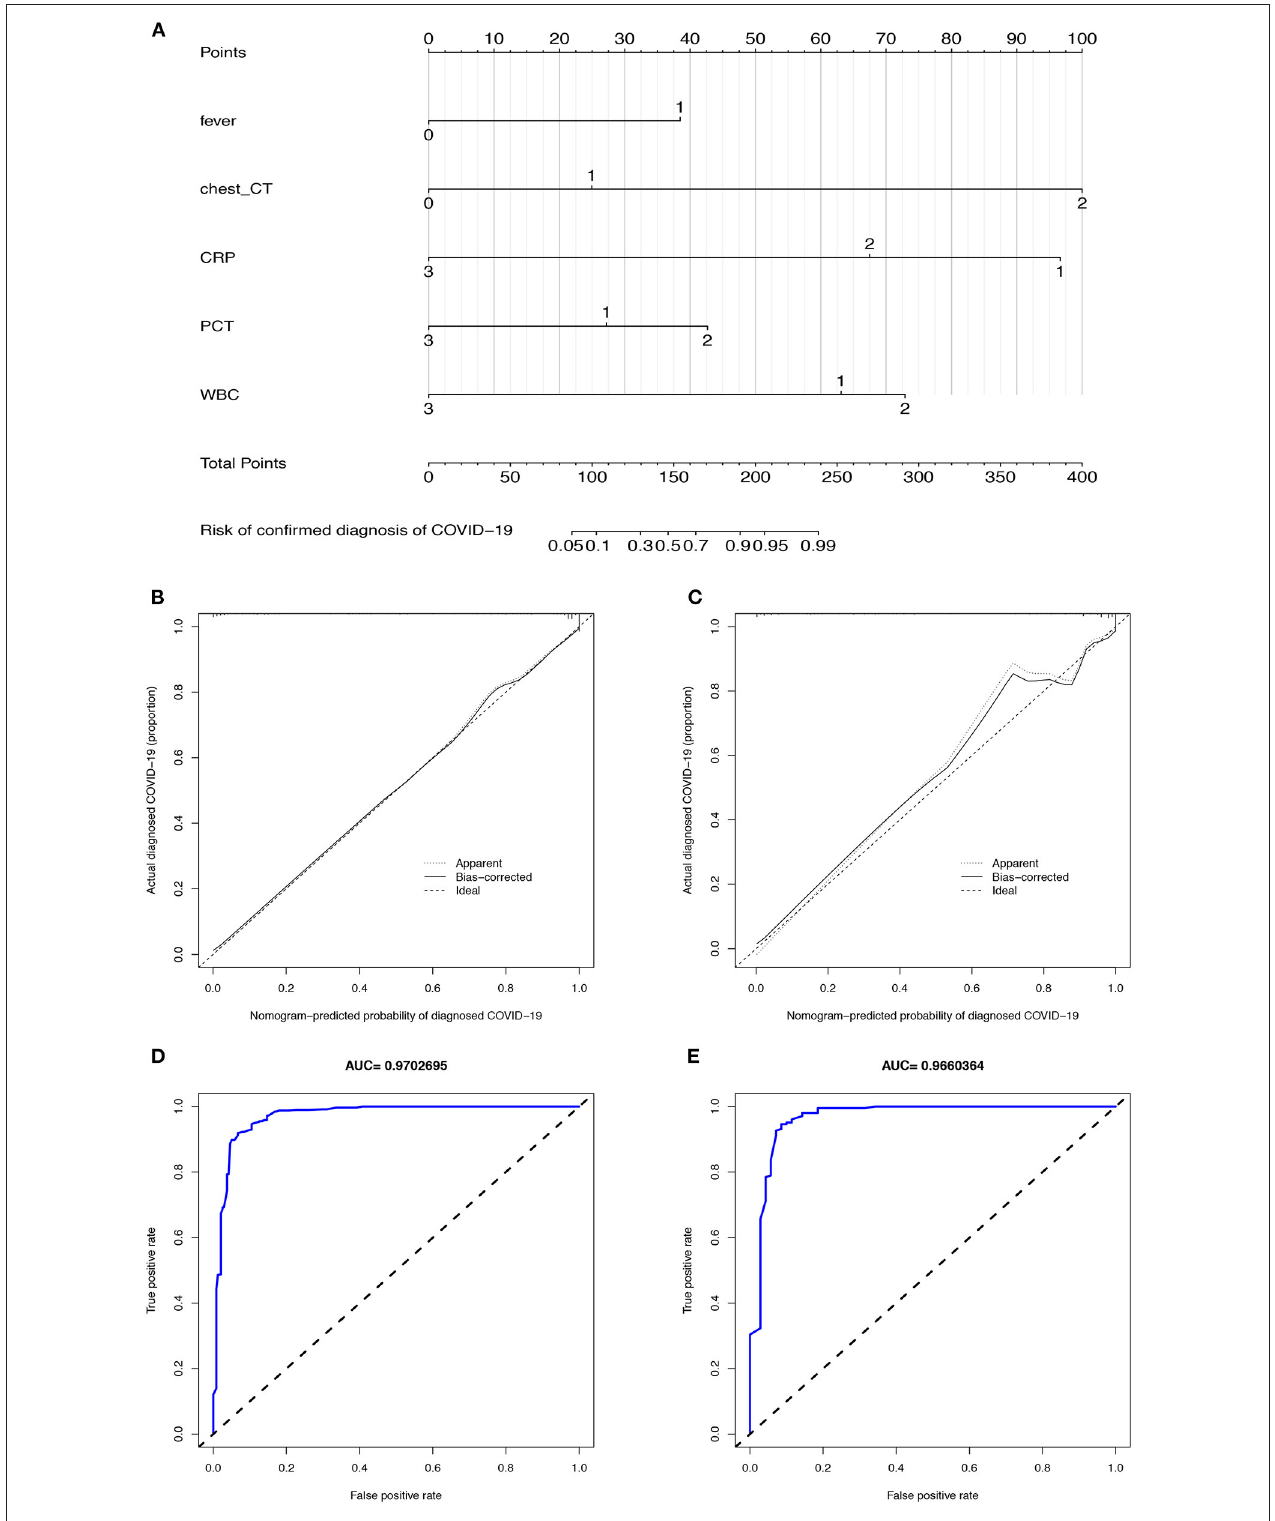
FIGURE 3 | The CIAAD nomogram and its discrimination performance in training and validation cohort. (A) . The CIAAD nomogram was developed in the training cohort based on fever, chest CT, CRP, PCT, and WBC. (B) . Calibration curve of the CIAAD nomogram in the training cohort. Calibration curves depict the calibration